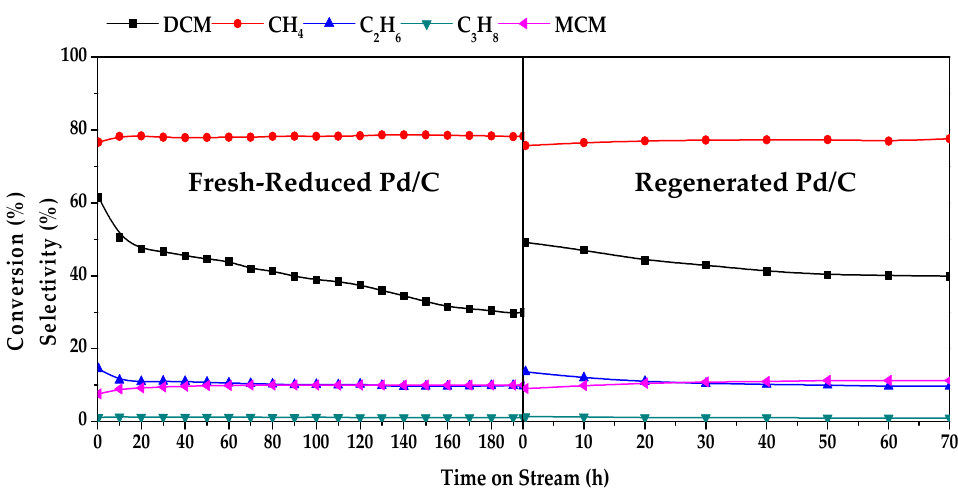
Figure 2. Evolution of DCM conversion and selectivity to reaction products upon time on stream in the HDC of DCM with the fresh-reduced and regenerated Pd / C (the catalyst regeneration in air flow 50 mL min − 1 , 250 ◦ C for 12 h, τ = 0.4 kg h mol − 1 ).